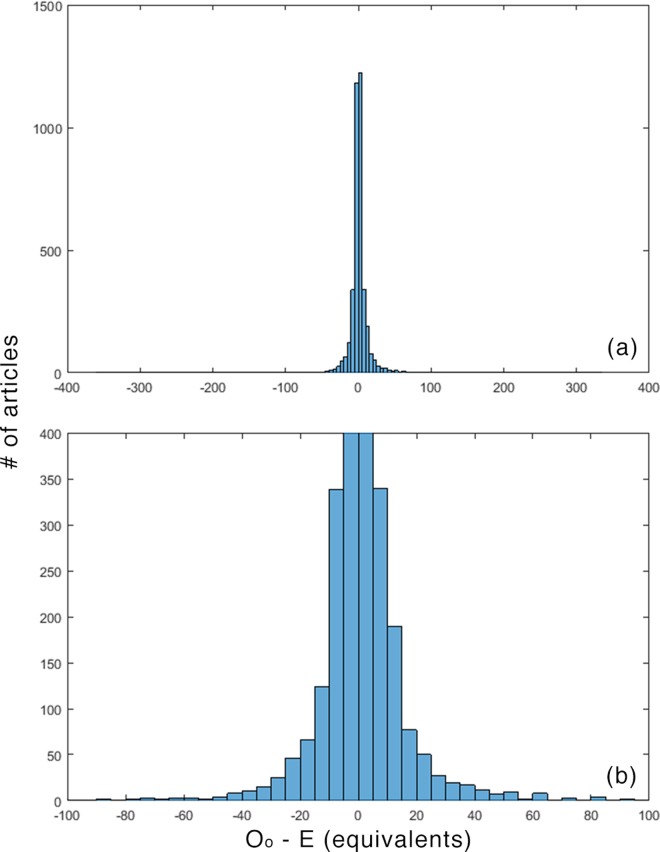
Oo—E for equivalents.(a) overall (b) detail.